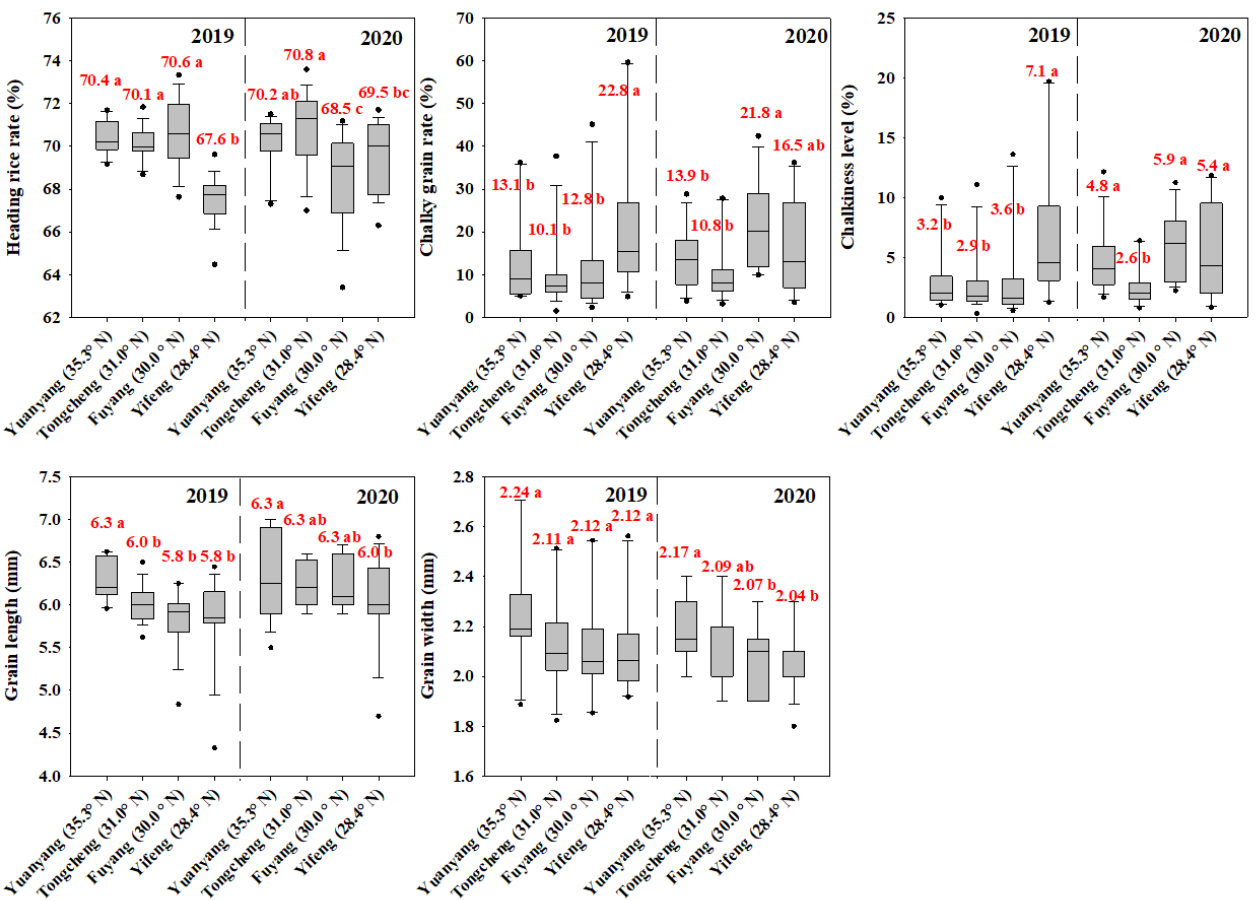
Figure 4. The box plot graph of the rice quality traits (including head rice rate, chalky grain rate, chalkiness level, grain length and grain width) of six cultivars in different areas. The value represents the mean yield of six cultivars in each area and year. Means followed by different letters are significantly different according to LSD (0.05) for each year.